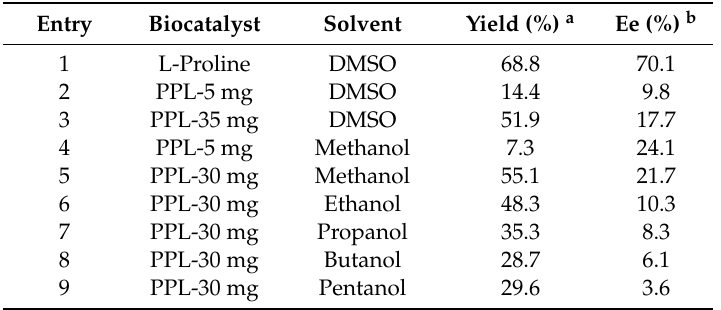
Table 3. Determination of optical purity for reactions with PPL and